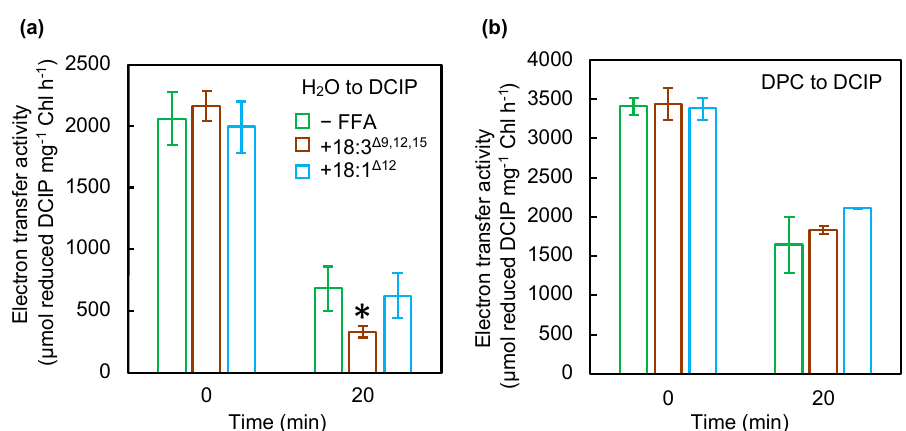
Figure 2. Effect of unsaturated C18 FFAs on electron transfer in PSII. Thylakoid membranes were prepared from cells exposed to strong light at 1500 µ mol photons m − 2 s − 1 at 32 ◦ C without (green bars) or with 18:3 ∆ 9,12,15 (brown bars) or 18:1 ∆ 12 (light blue bars) at a final concentration of 50 µ mol L − 1 . The electron transfer activity from H 2 O ( a ) or diphenylcarbazide (DPC) ( b ) to 2,6-dichlorophenolindophenol (DCIP) was calculated by changes in absorbance at 580 nm due to the reduction of DCIP at 32 ◦ C under strong light at 1500 µ mol photons m − 2 s − 1 . To measure the electron transfer rates from DPC to DCIP, the oxygen-evolving complex (OEC) in thylakoid samples was disrupted by incubation with 5 mM NH 2 OH for 5 min on ice. Values are the means ± SD (bars) of three independent experiments. Asterisks indicate statistically significant differences (* p < 0.05; Student’s t